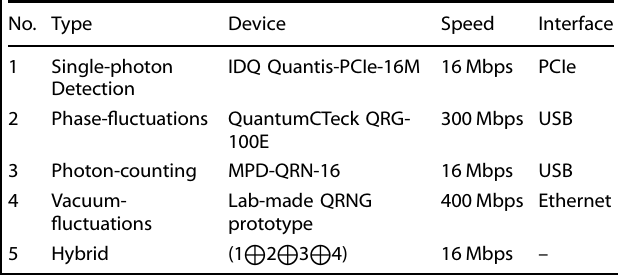
Table 1. Quantum random number generation from different entropy